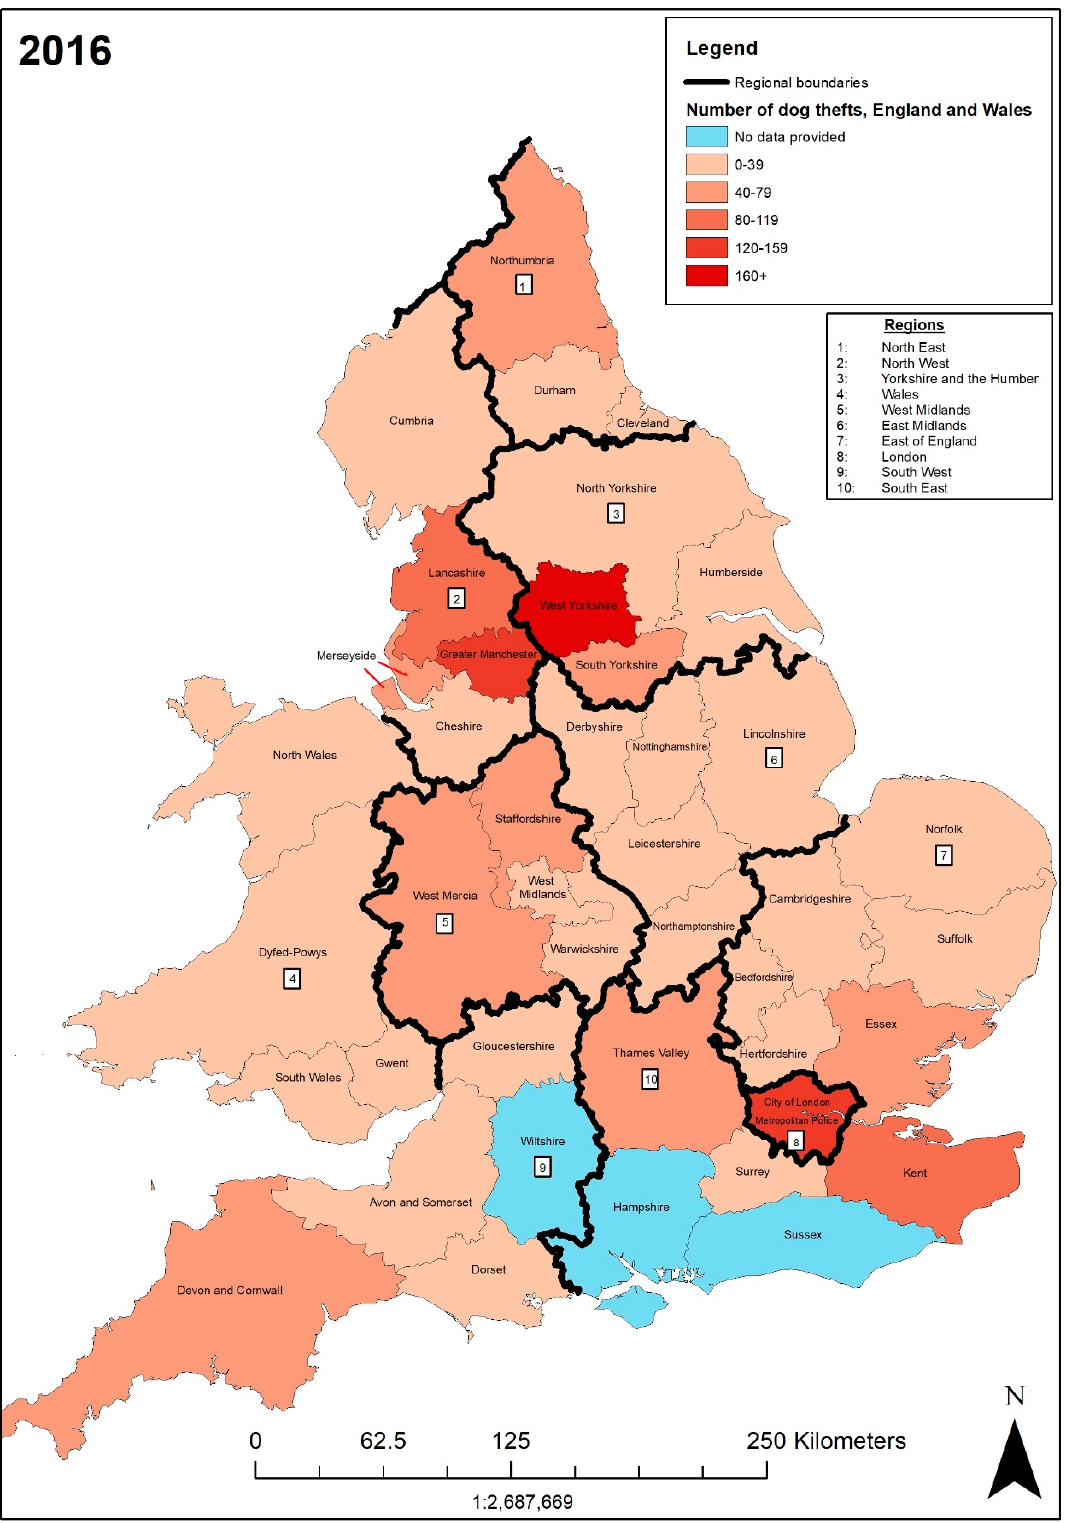
Figure 3. Number of dog theft crimes recorded by each police force in England and Wales in 2016. In 2017, the forces with the highest numbers of dog theft crimes were West Yorkshire (172), Metropolitan (169), Greater Manchester (146), Kent (130), and Lancashire (93). The lowest recorded dog theft crime numbers were in Cheshire (4) and the City of London (0). Similarities emerge from the 2016 data as the five police forces with the highest DTCs in 2016 also had the greatest number of